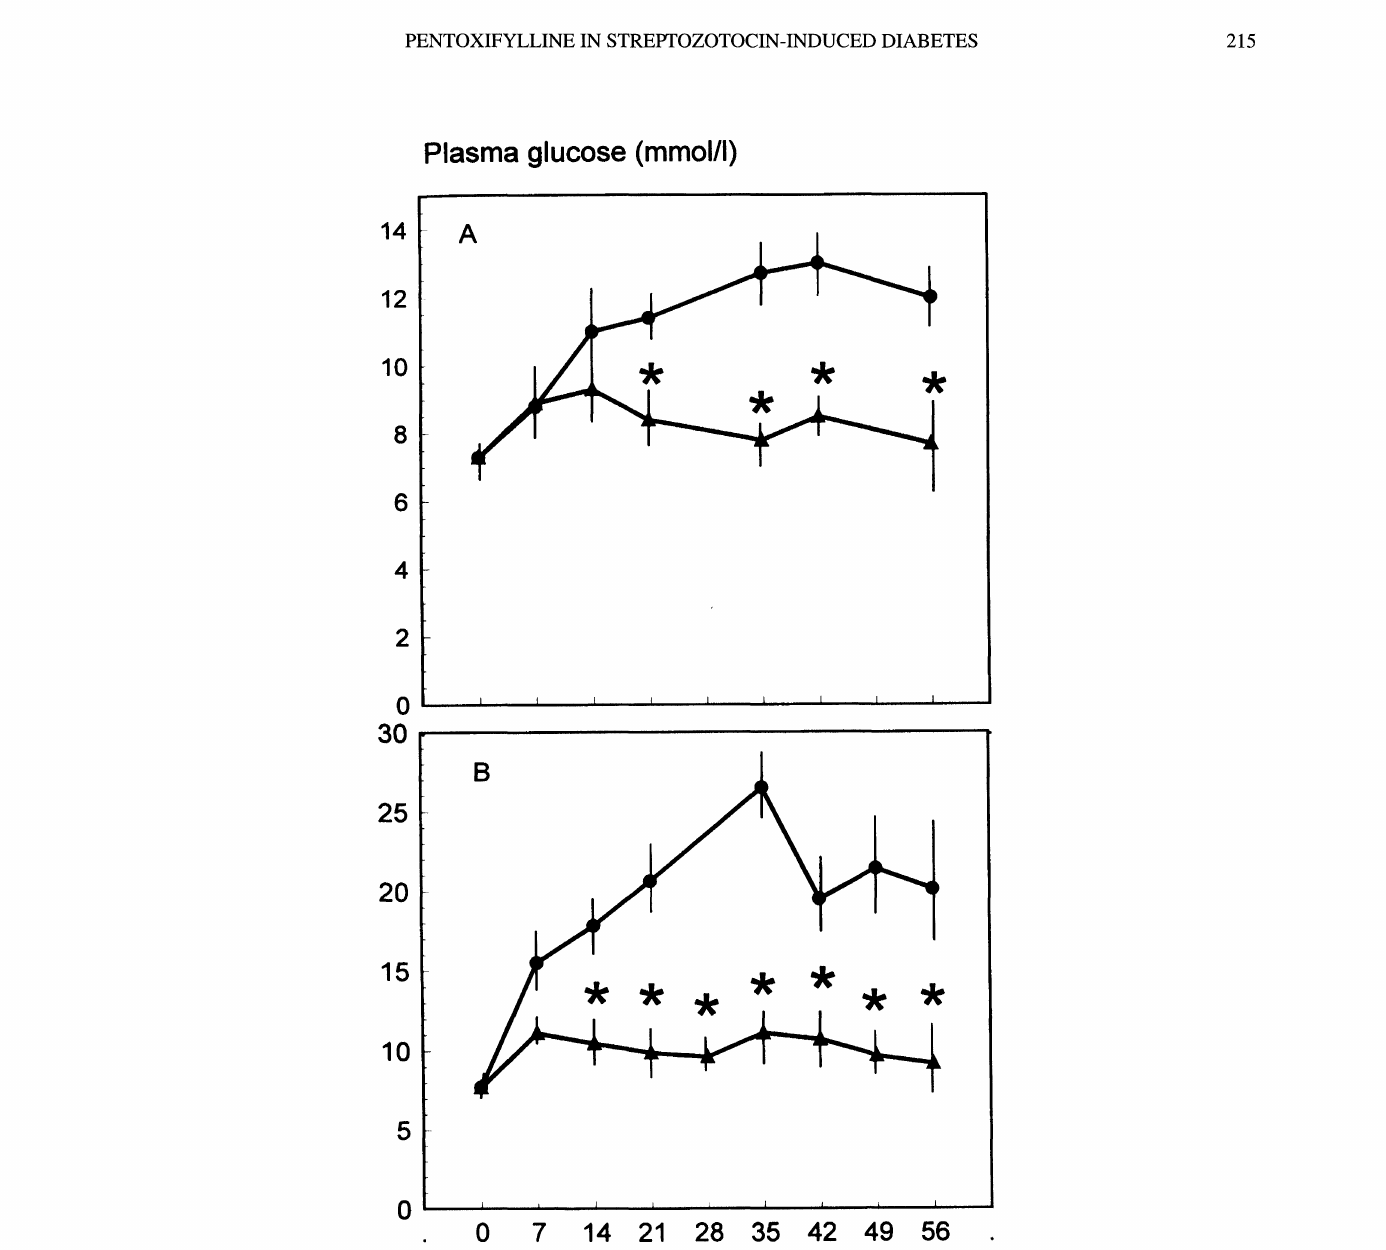
FIGURE Effects of PTX treatment on the development of MLD-SZ-induced hyperglycemia in mice and rats. Plasma glucose levels, deter- mined in CBA/H mice (A) and DA rats (B) receiving MLD-SZ for 5 consecutive days (o), or animals treated with MLD-SZ in conjunction with PTX from day 0 to day 9 in relation to the first SZ injection (,). Significantly different from the value of MLD-SZ-treated but non-PTX-treated control animals: *P<0.05; Student’s